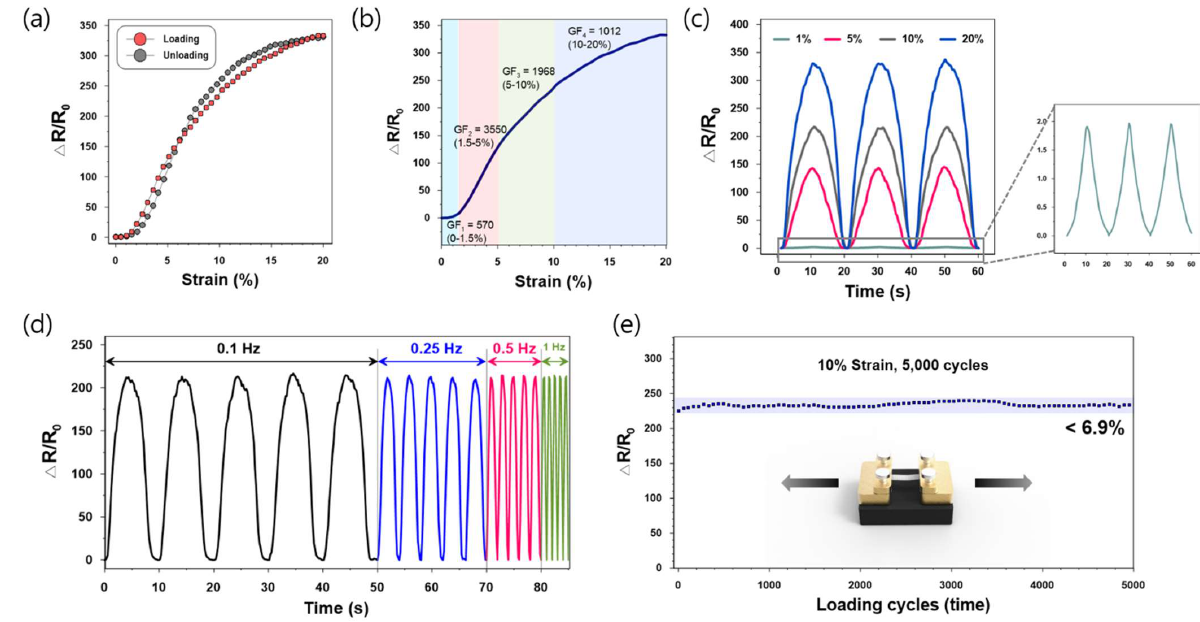
Figure 6. Strain sensing properties of the pre-cracked Ag/SWCNT sensor including ( a ) Hysteresis; ( b ) Gauge factors; ( c ) Signals at different loading strains; ( d ) Responses at different loading frequencies; ( e ) Durability after 5000 stretching– releasing cycles.